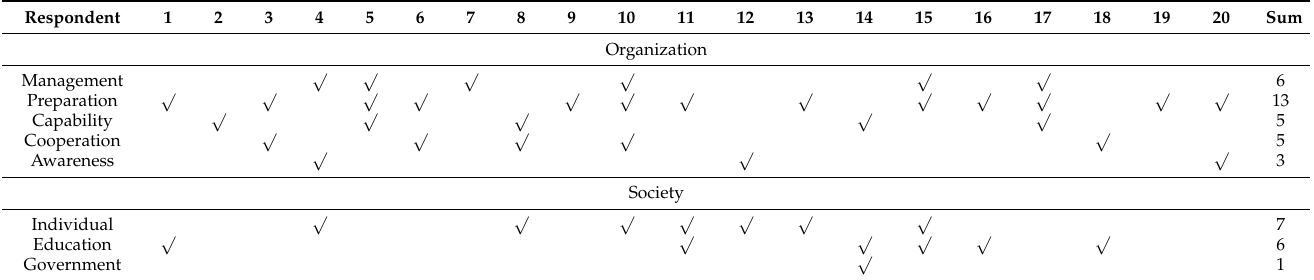
Figure 5. Summary of strategies to create trust in BIM-based construction projects. Table 5. Strategies to create trust in BIM-based construction projects.